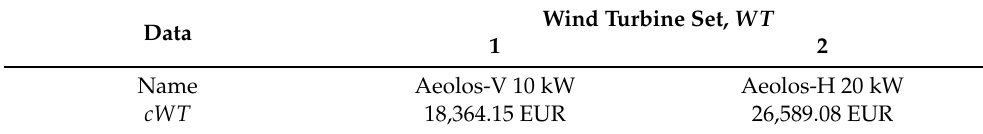
Table 3. Description of wind turbine set: designation and unit cost.